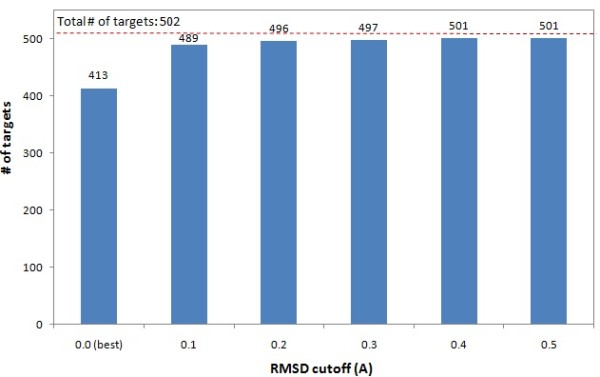
Number of the targets whose Pareto-optimal decoys contain at least one decoy within certain RMSD cutoff from the best decoy. The Pareto-optimal decoys can effectively cover the best decoy or one close to the best decoy in a target's decoy set.